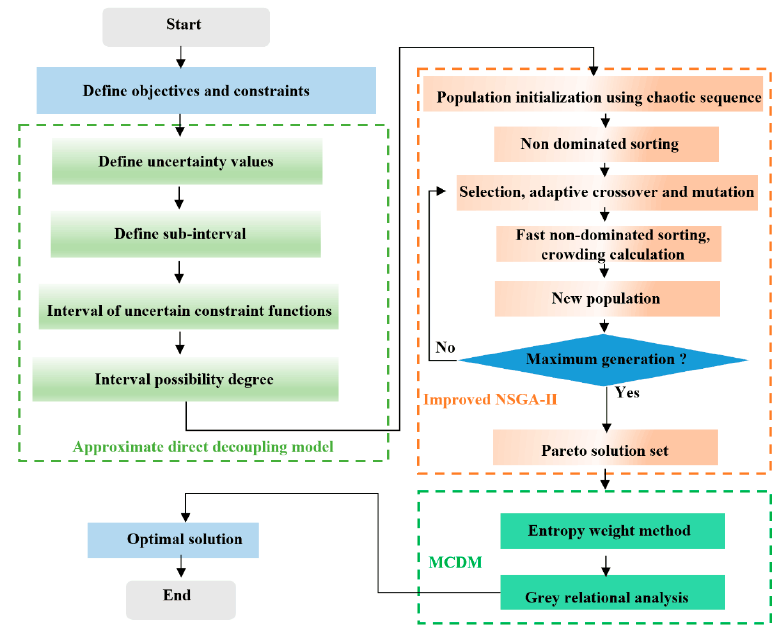
Figure 1. Main steps of MUOD framework.